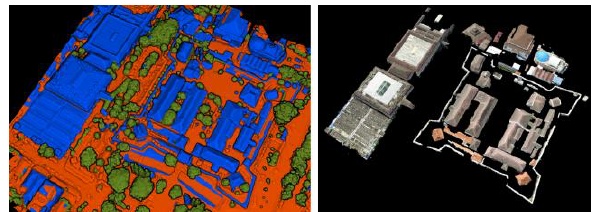
Figure 11. Pointclouds classification results. The building denoted by blue color, the vegetation as green color and the ground as brown color.